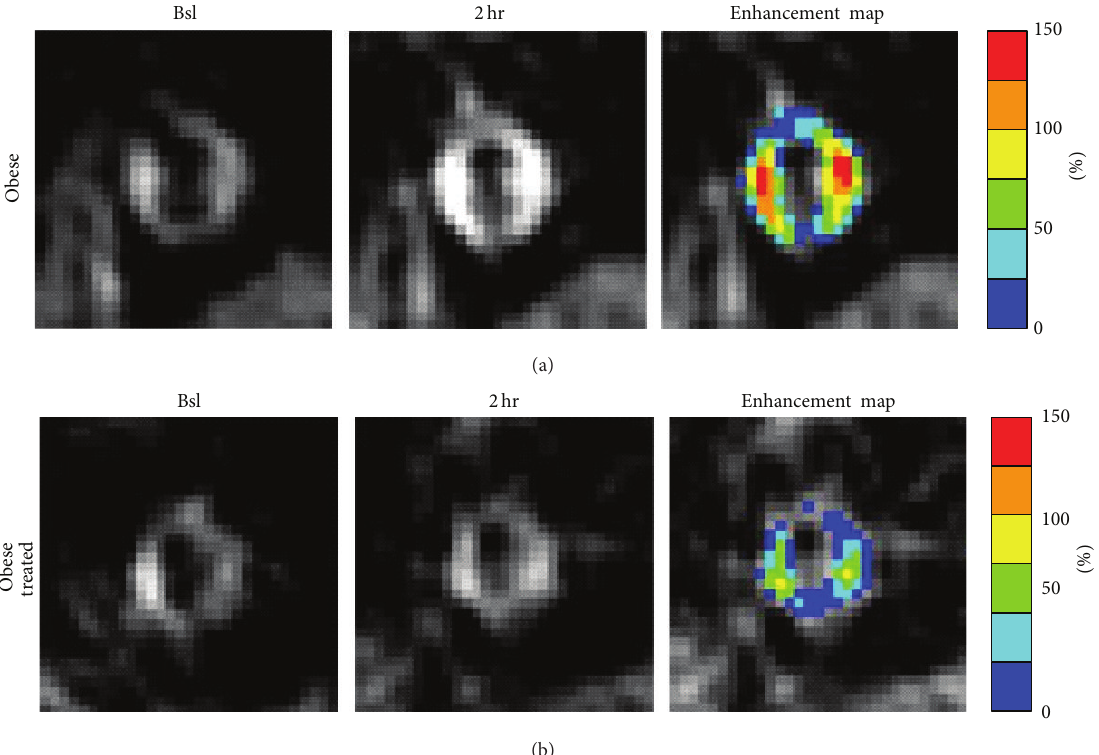
Figure 4: Molecular imaging of aortic angiogenesis with targeted perfluorocarbon nanoparticles targeted to the 𝛼 ] 𝛽 3 -integrin. Images show the abdominal aorta of an obese JCR rat (a) and an obese rat treated with benfluorex (b) at baseline (Bsl) and 2 hours (2 hr) after injection of nanoparticles.HighMRIsignalenhancement(Enhancementmap)wasobservedintheuntreatedobeseanimal,indicatingactiveangiogenesis in the aortic wall to support the development of atherosclerotic lesions. Benfluorex reduced the aortic enhancement in the treated animal, suggesting reduced angiogenesis in the vessel wall. Reprinted with permission from